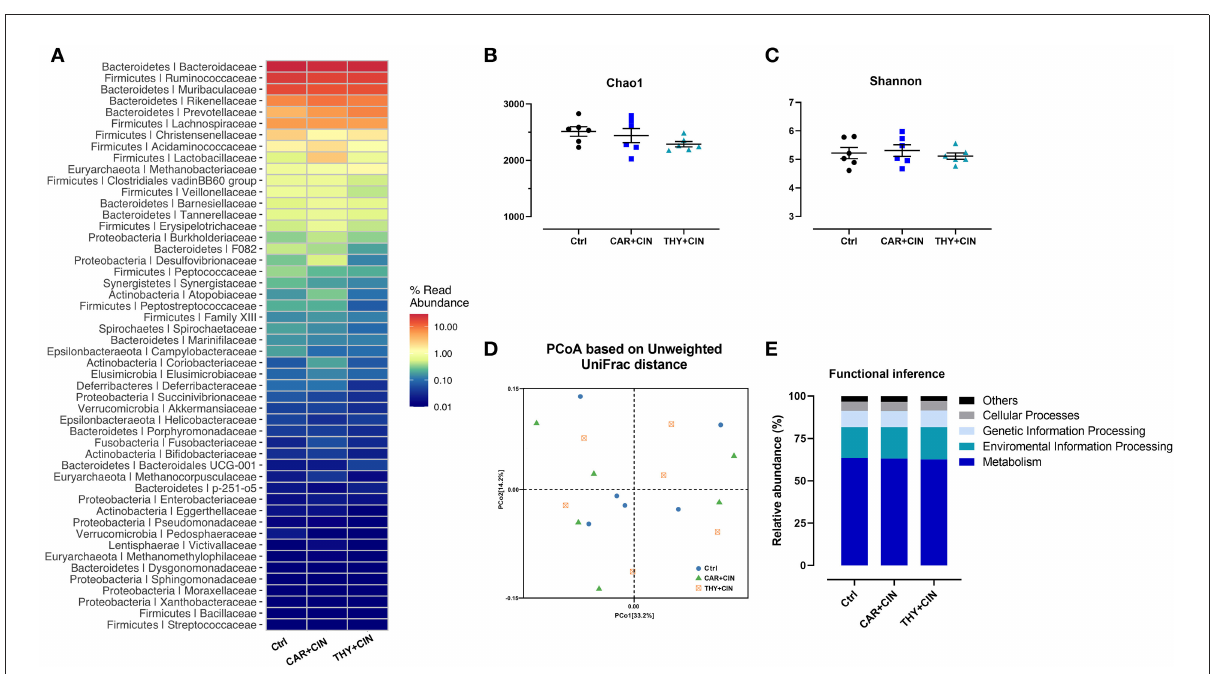
FIGURE4 The effect of dietary cinnamaldehyde with carvacrol (CAR + CIN) or thymol (THY + CIN) essential oils on cecal microbiota. (A) The relative abundances of bacterial communities at the family level; (B,C) Chao1, and Shannon indicesexes were used to assess diversity and evenness at the familyiarlevel, (D) principal coordinate analysis plot (PCoA) of caecum microbiome diversity based on Unweighted UniFrac distance. (E) Functional predictions for the cecal microbiome based on Kyoto Encyclopedia of Genes and Genomes (KEGG) analysis. Significant differences were declared at a P -value < 0.05. In this study, a total of 384 50-week-old Hy-line brown laying hens were randomly divided into a basal diet (Ctrl), a basal diet with 100 mg/kg of essential oils consisting of 4.5% of cinnamaldehyde with 13.5% of carvacrol (CAR + CIN), and a basal diet containing 100 mg/kg of essential oils composed of 4.5% of cinnamaldehyde with 13.5% of thymol (THY + CIN) for 6